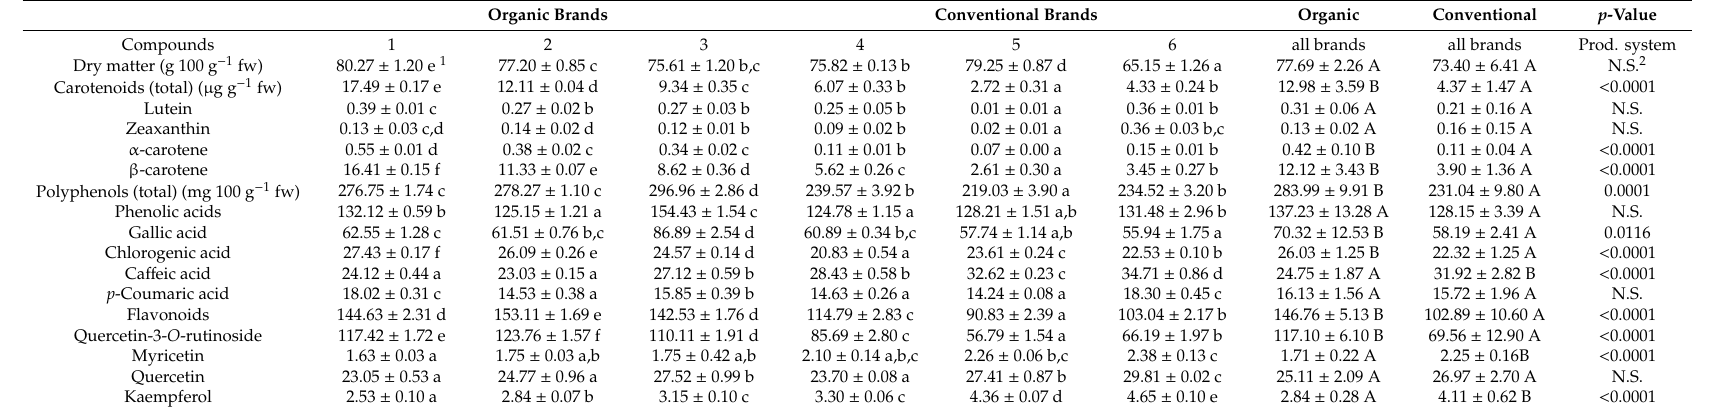
Table 1. The content of dry matter, carotenoids, and phenolic compounds in dried apricots of selected organic and conventional brands. Organic Brands Conventional Brands Organic Conventional